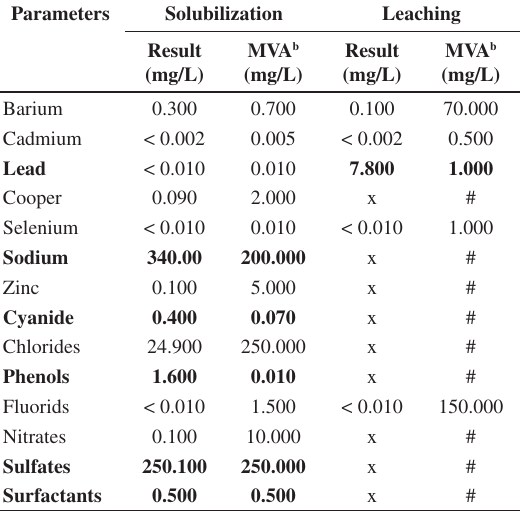
Table 2. Result of the leaching and solubilization test, according to the NBR 10004/2004 standard 17 , which classifies the grinding dust as a hazardous waste (class